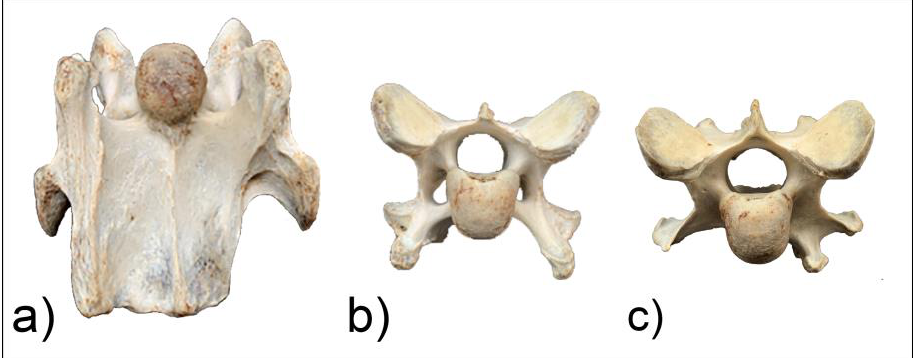
Figure 8. The ventral aspect of C6 ( a ) and cranial views of C6 ( b ) and C7 ( c ) of horse F1. On postmortem examination of F1, the absent left caudal lamina of C6 was transposed onto the ventrolateral aspect of C7 creating a gross left to right asymmetry in C7 as well as the C6 vertebrae.